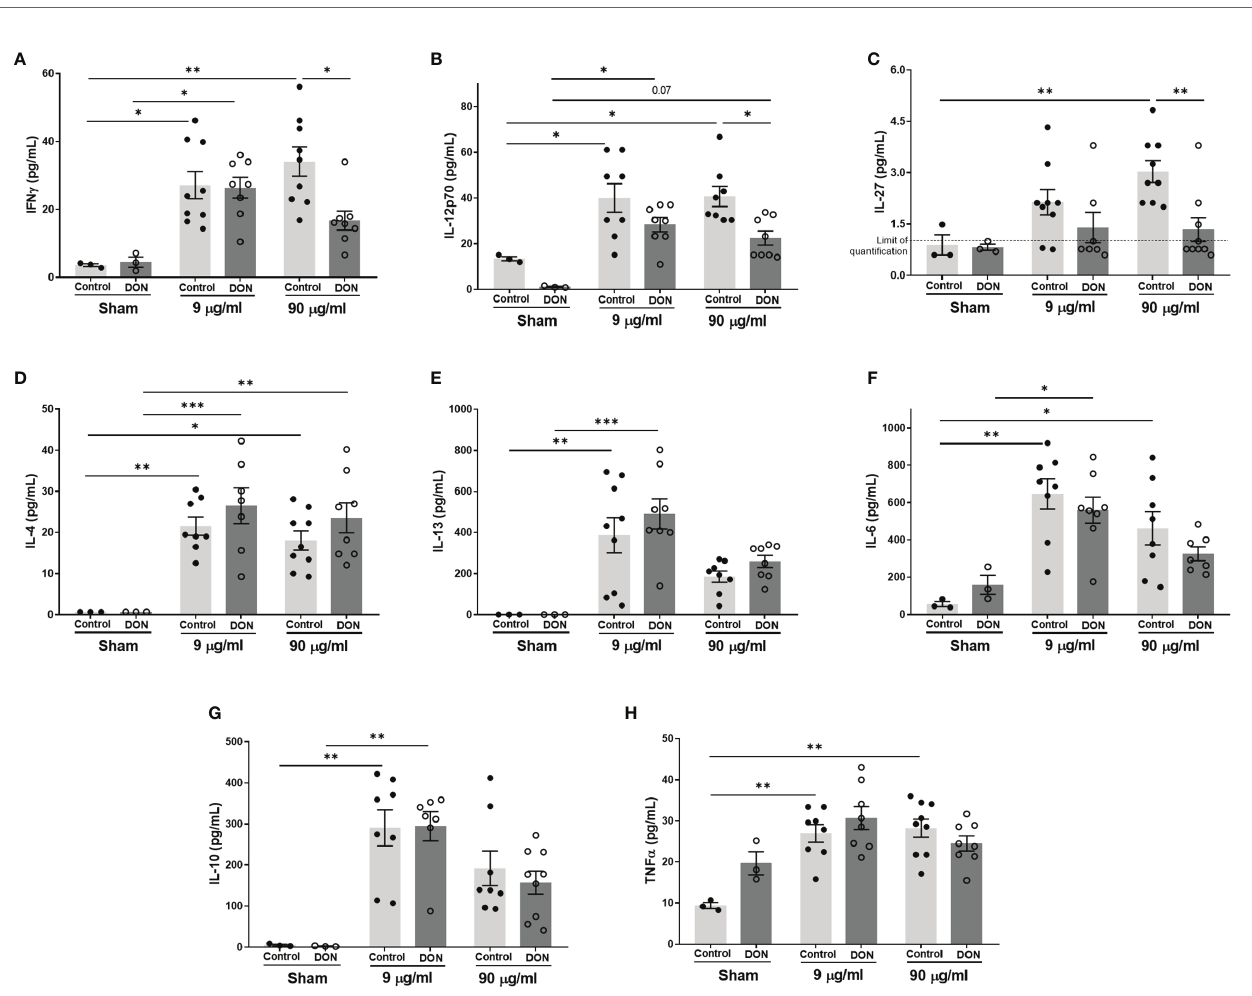
FIGURE 7 | Maternal deoxynivalenol (DON) exposure modulated the cytokine production of splenocytes of male offspring co-cultured with in fl uenza-loaded bone marrow-derived murine dendritic cells (DCs) ex vivo . Pregnant mice fed either a control or DON-contaminated diet (12.5 mg/kg) during pregnancy and lactation period. Male offspring received subcutaneous injections of either phosphate-buffered saline (PBS, sham) or In fl uvac (9 and 90 µg/mL) after weaning. 10 days after the second injection, male offspring were sacri fi ced and collected splenocytes were co-cultured with in fl uenza-loaded bone marrow-derived DCs from healthy, untreated mice. (A – H) Interferon (IFN)- g , interleukine (IL)-12p70, IL-27, IL-13, IL-4, IL-6, IL-10 and tumor necrosis factor (TNF)- a concentrations. Data are presented as mean ± SEM. *p < 0.05, **p < 0.01 and ***p < 0.001 indicate statistical